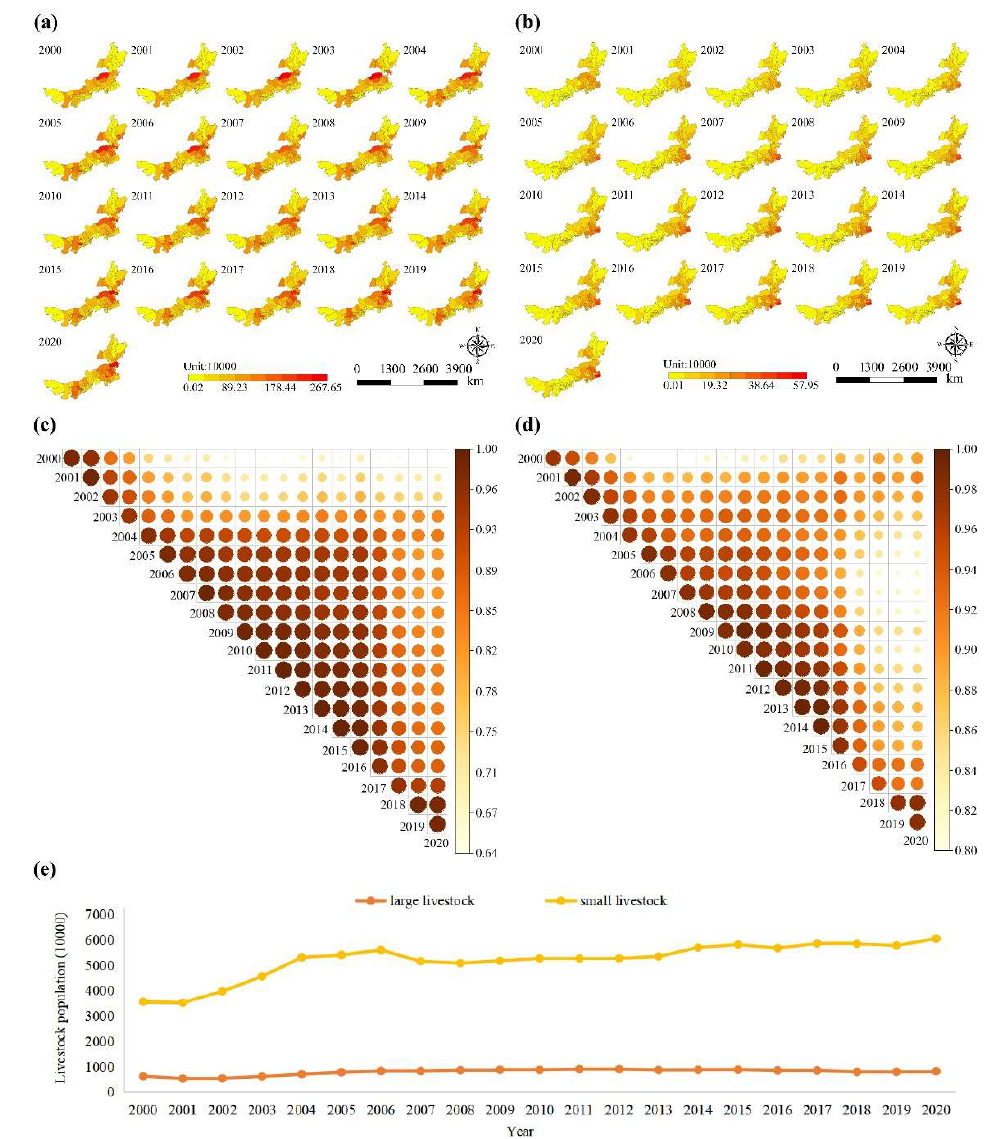
Figure 4. Dynamics of livestock in IM from 2000 to 2020. Distribution of ( a ) small livestock and ( b ) large livestock, ( c ) correlation matrix of small livestock and ( d ) large livestock, ( e ) trends of livestock change in IM.